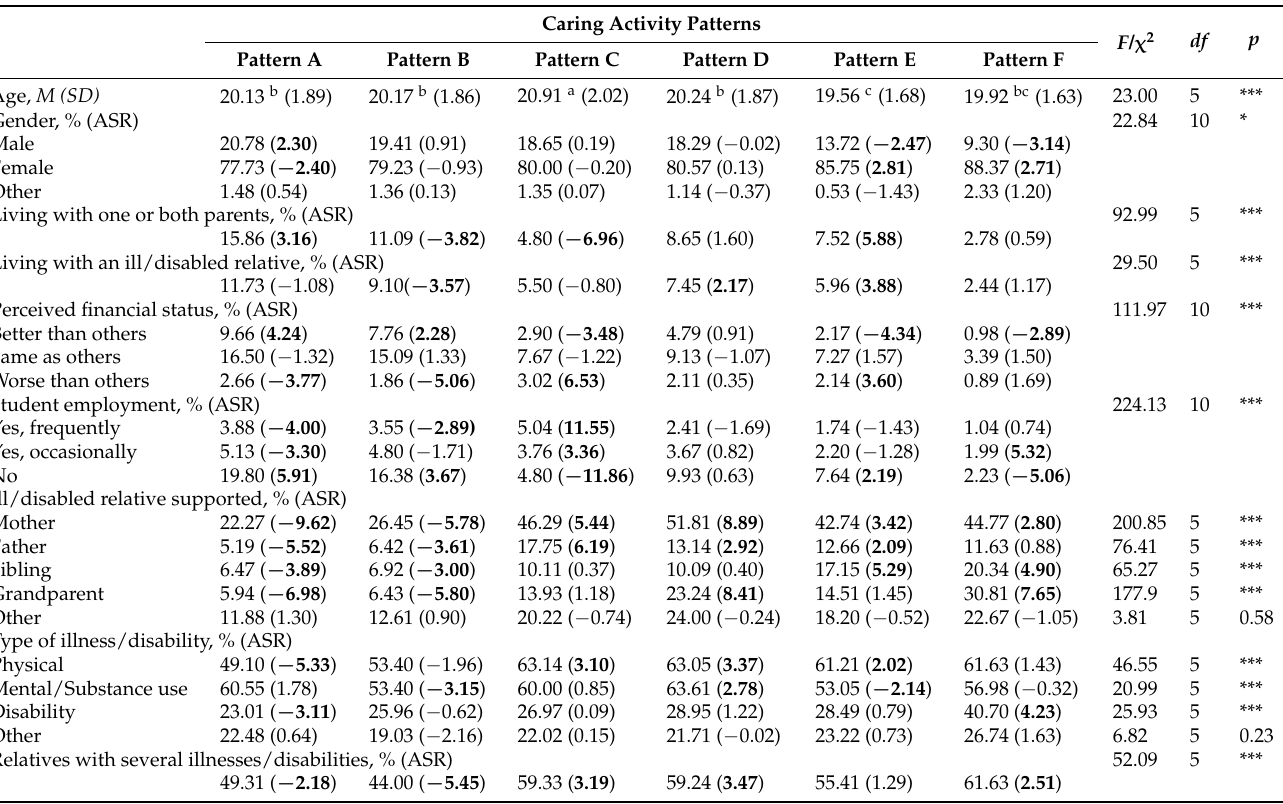
Table 3. Distribution of participants regarding age, gender, living arrangements, financial sta- tus, ill/disabled relative being supported, and relative’s type of illness/disability across caring activity